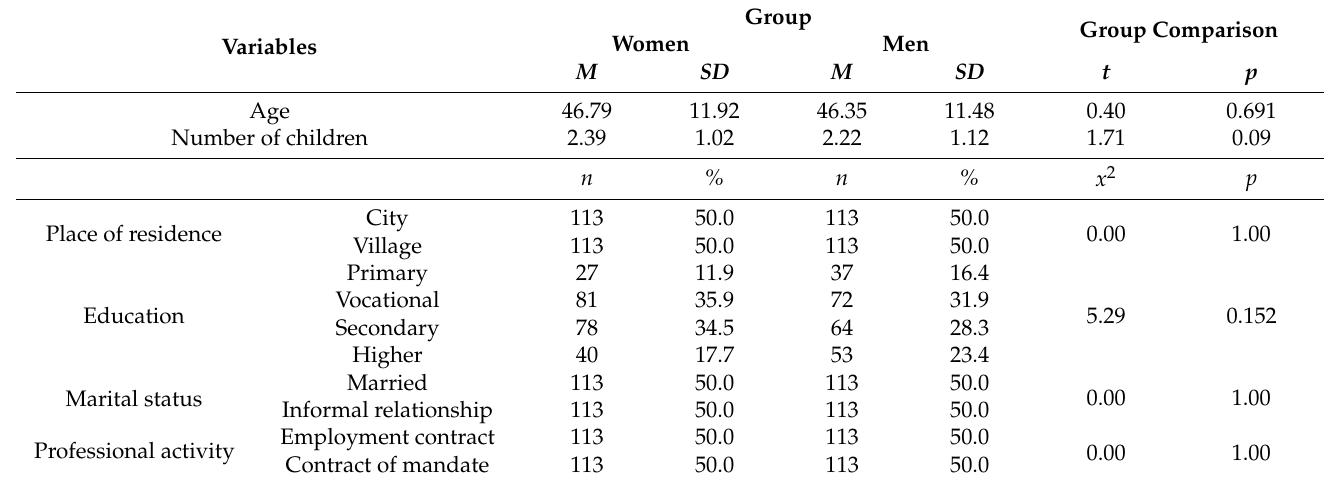
Table 1. Sociodemographic characteristics of the surveyed women and